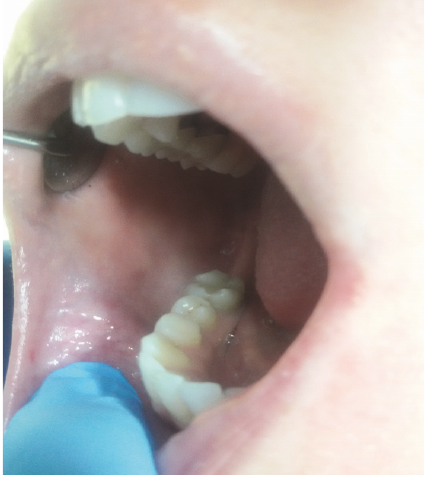
Figure 3: The lesion completely healed after a